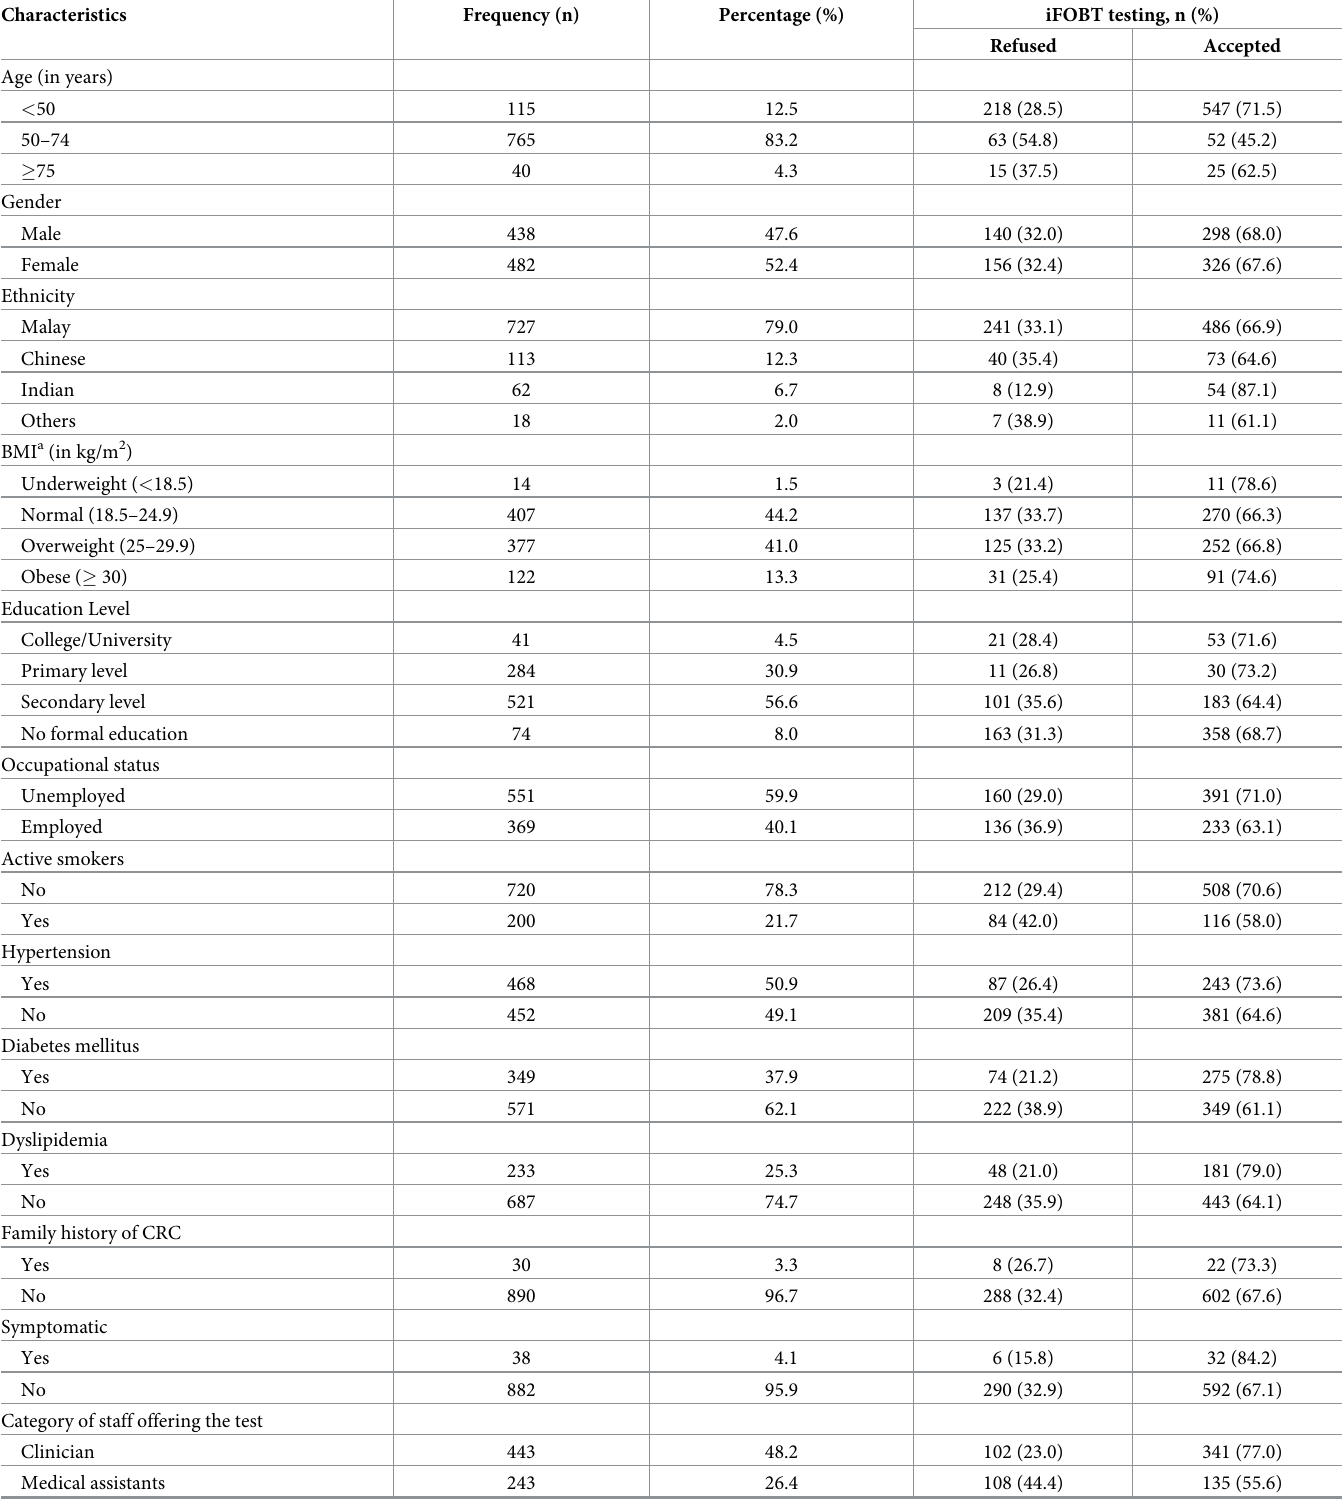
Table 1. Characteristics of individuals who were offered an iFOBT (n = 920).